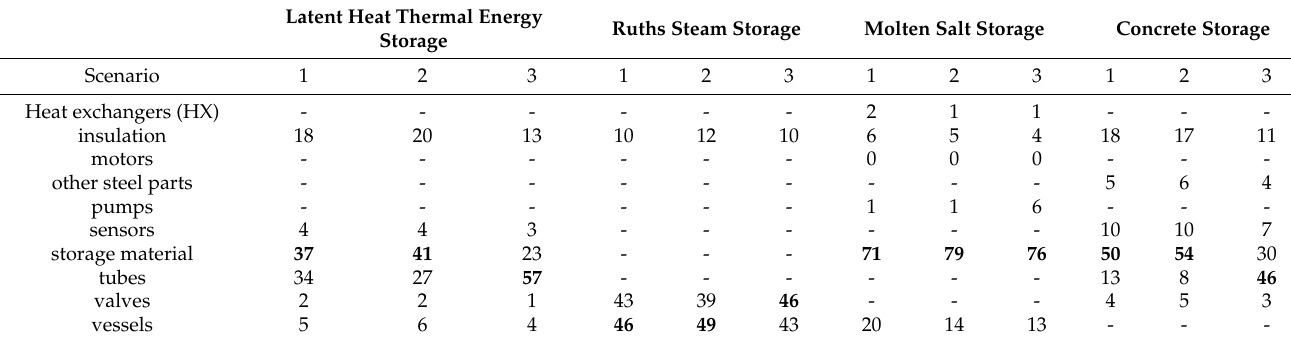
Table 7. Cost structure for Case 2 in percentage of total storage costs (rounded). Dominant cost drivers are printed in bold